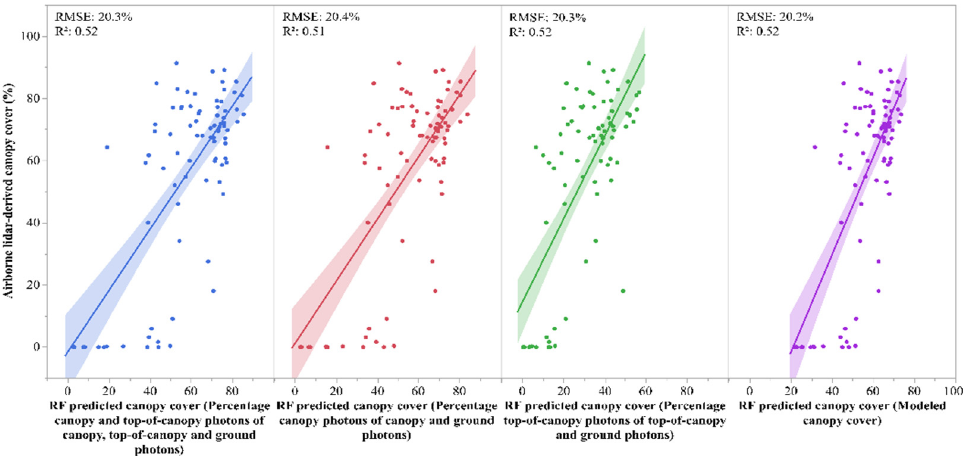
Figure 5. Pixel-level (30 m) airborne lidar-derived canopy cover versus RF-predicted canopy cover for SDFEC.